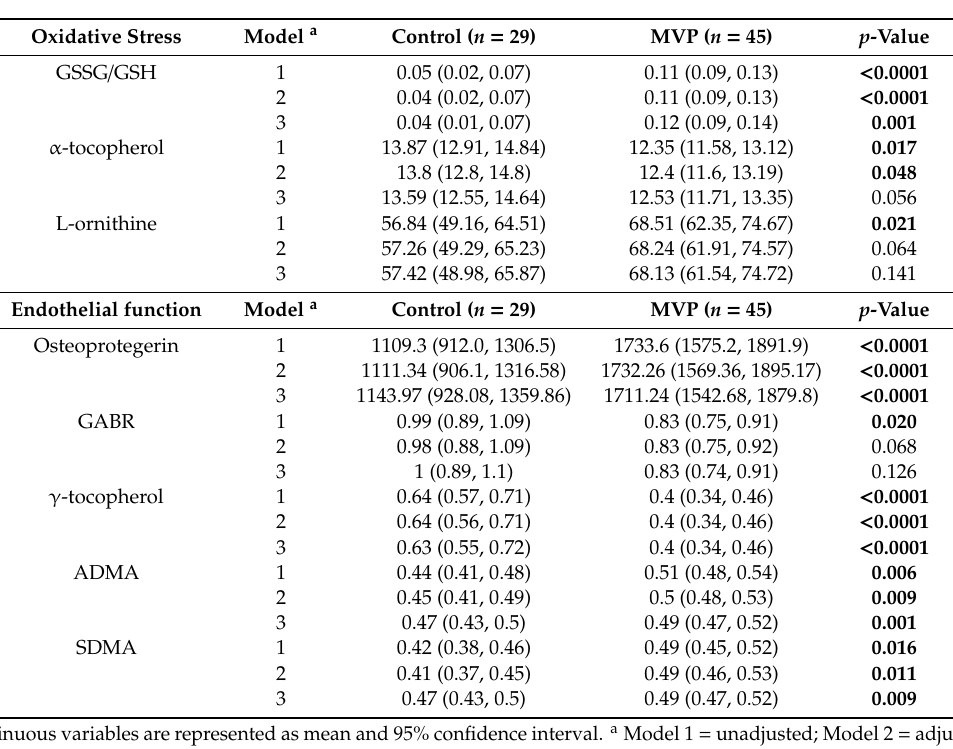
Table 3. Circulating biomarkers.